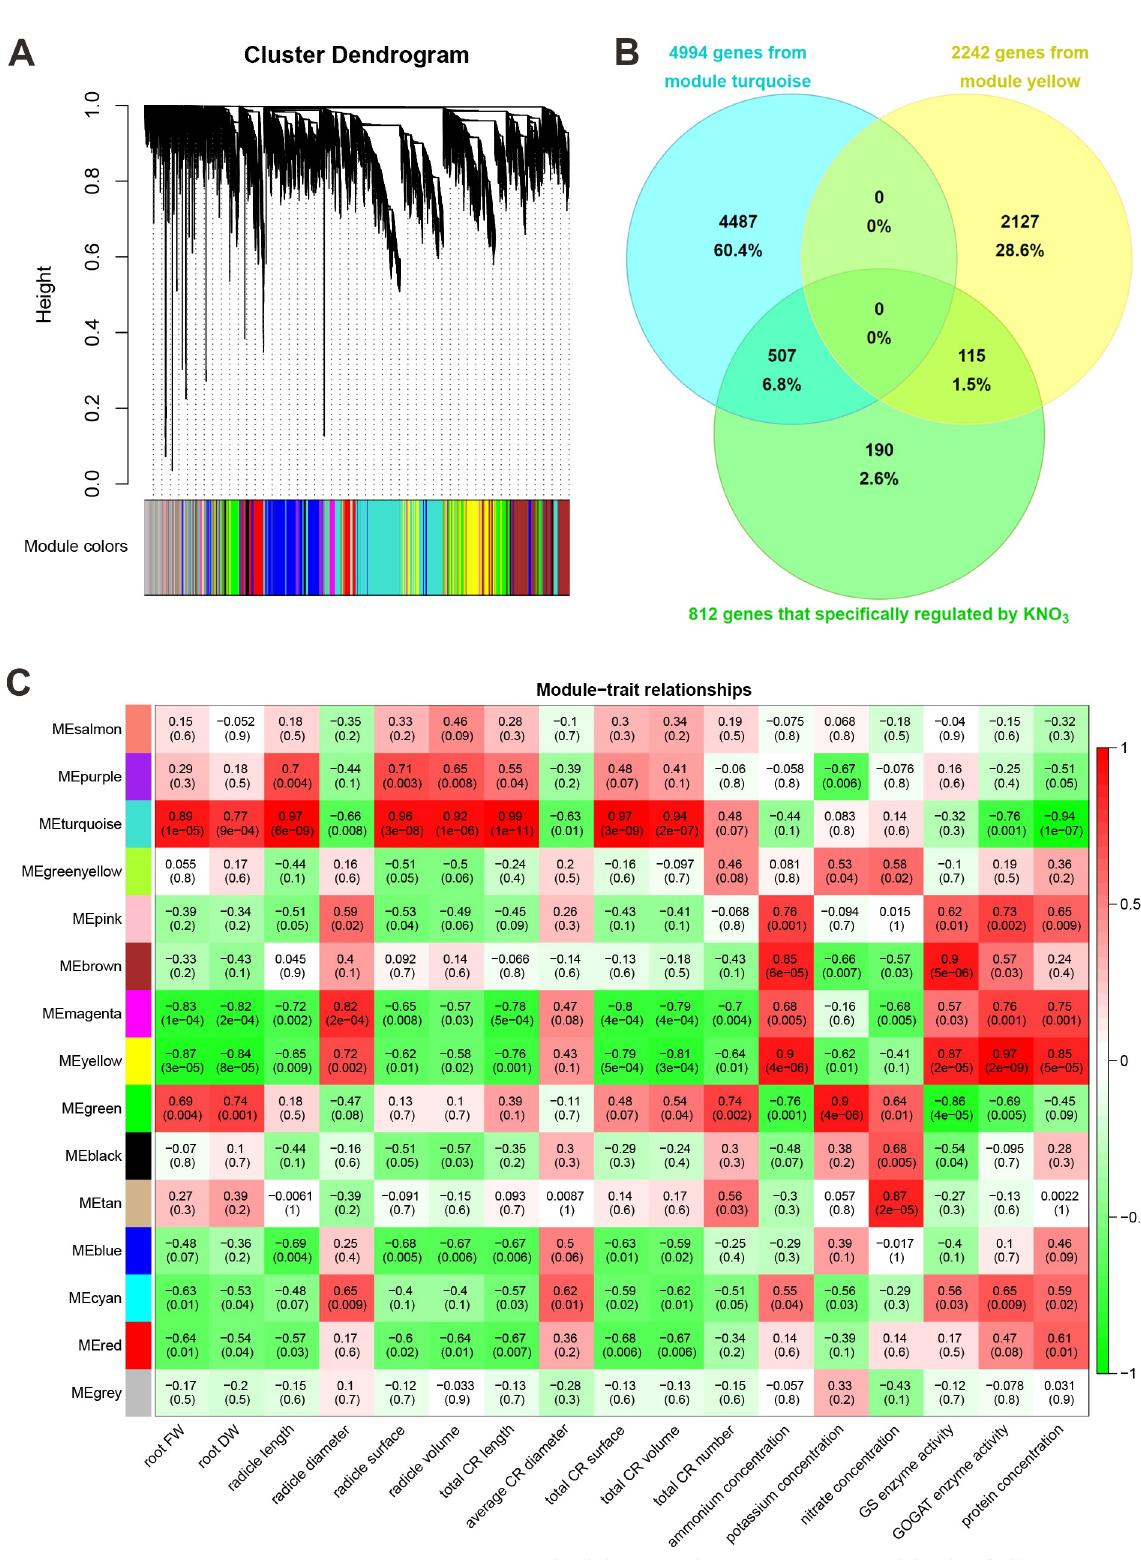
Fig 6. The weighted gene correlation network analysis. (A) Hierarchical cluster tree showing coexpression modules identified by WGCNA. Each leaf in the tree represents 1 gene. The major tree branch comprises 15 modules labeled by different colors. (B) Venn diagram showing